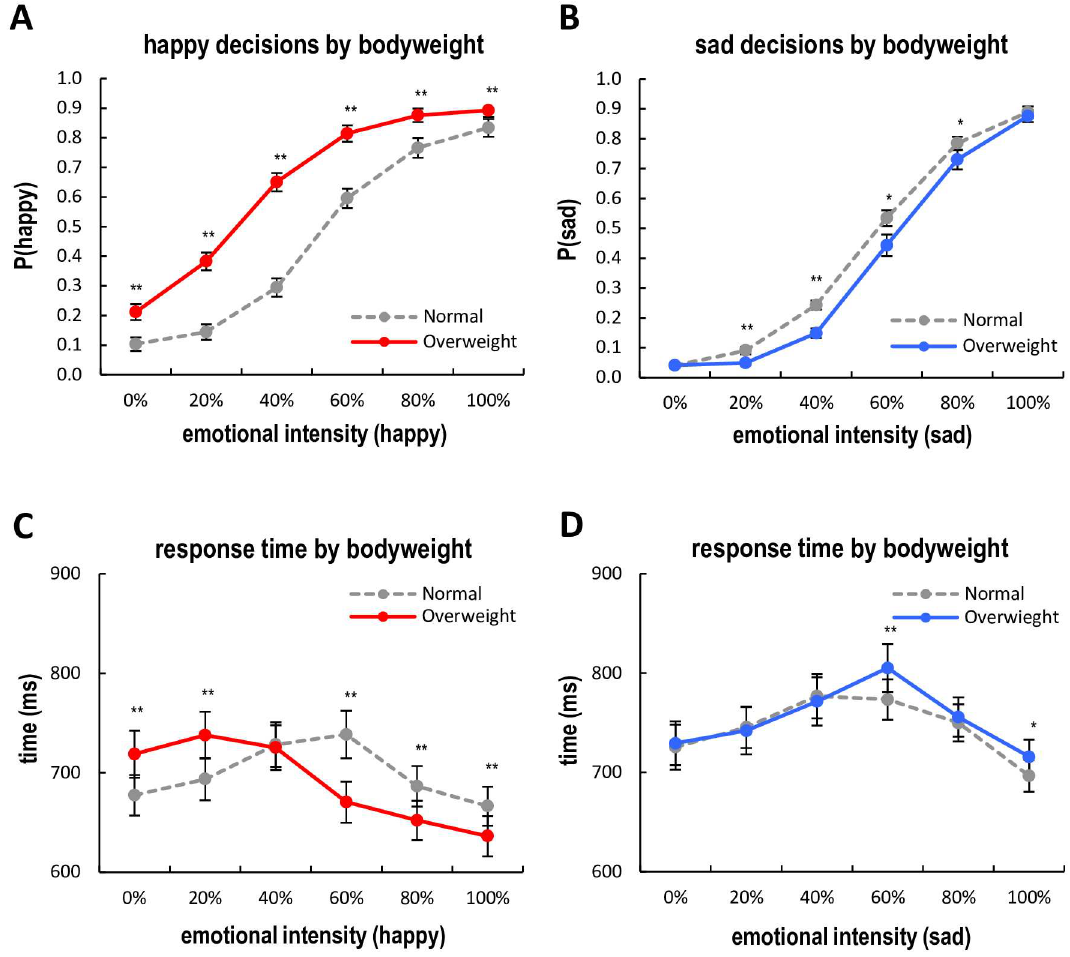
Fig 4. Behavioral findings. A. Averageprobability of happy decisions as a function of bodyweight and emotional intensity of faces (Experiment 1). B. Averageprobability of sad decisions as a function of bodyweight and emotional intensity of faces (Experiment 2). C. Response times of happy decisions (Experiment 1). D. Response times of sad decisions (Experiment 2). Error bars denote the standard error of the mean. * p < .05, ** p <